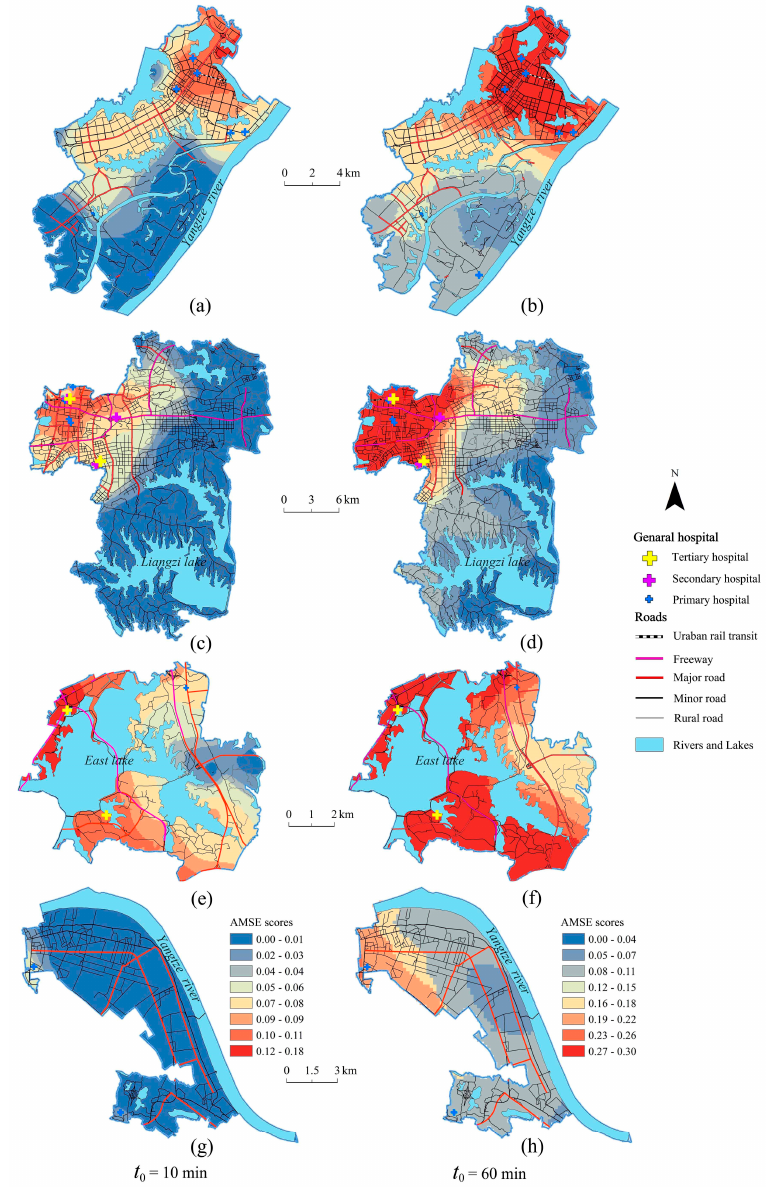
Figure 9. Spatial distribution of AMSE scores in different development zones. ( a , b ) are the images of AMSE scores in Economic & technological development zone (ETDZ); ( c , d ) are the images of AMSE scores in East lake high-tech development zone (ELHTDZ); ( e , f ) are the images of AMSE scores in East lake scenic area (ELSA); ( g , h ) are the images of AMSE scores in Chemical industry park